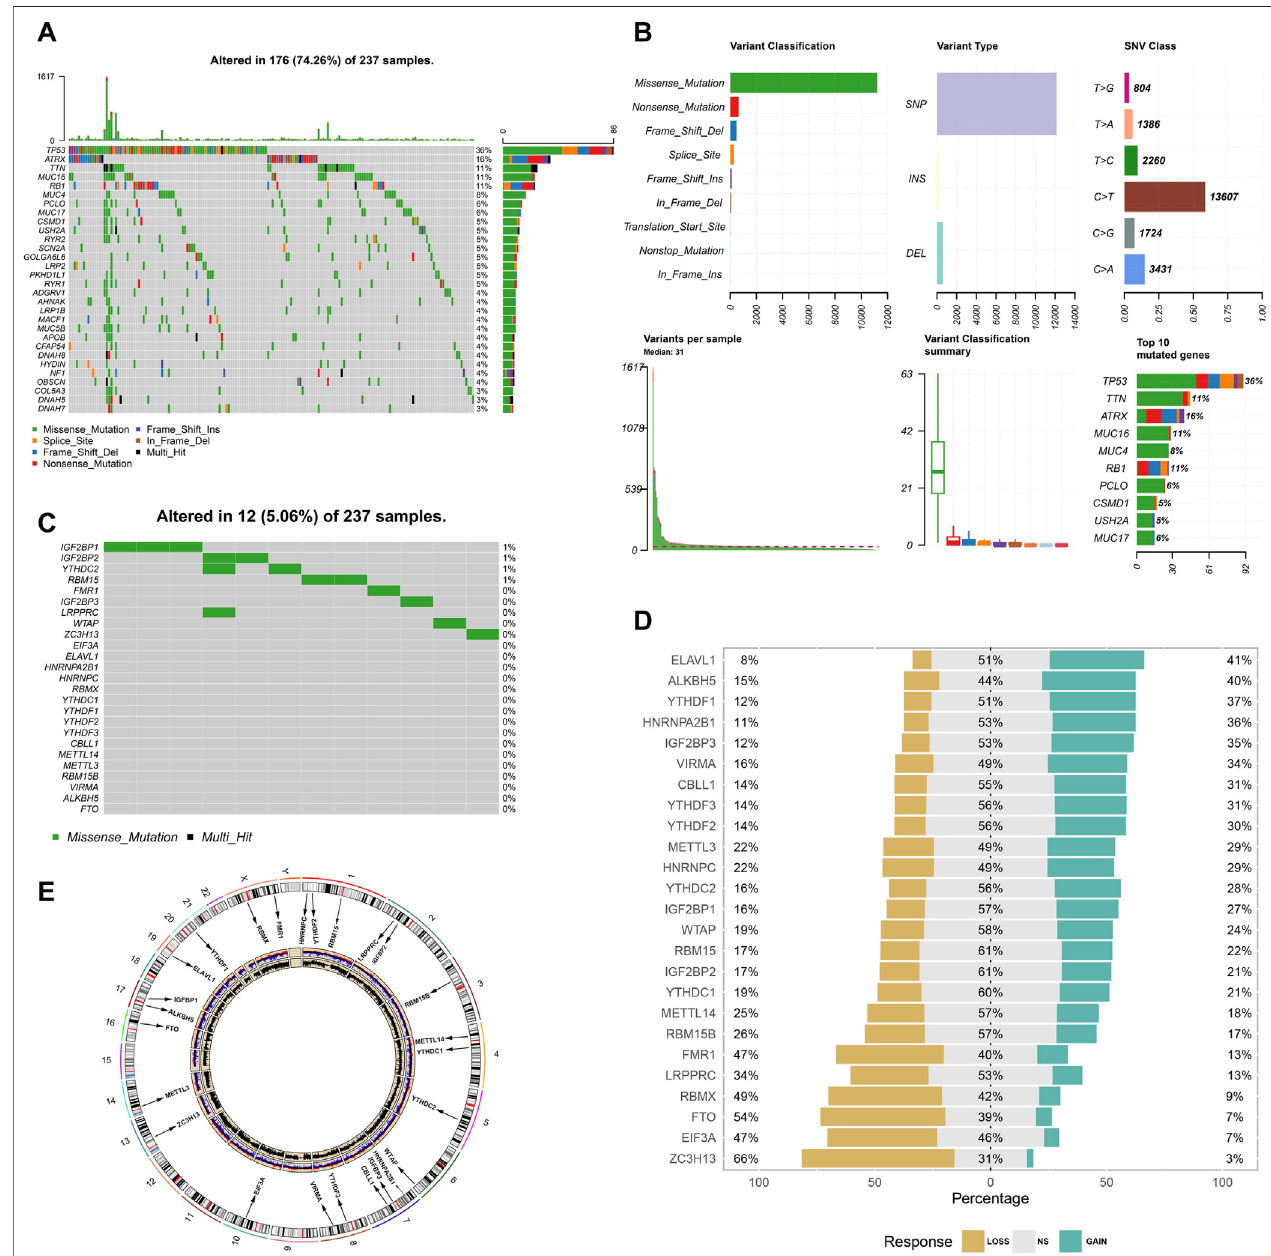
FIGURE1| LandscapeofsomaticmutationsandCNVofm6AregulatorsinSTS. (A) SummaryofsomaticmutationsinSTS; (B) variantclassi fi cationsofmutations in STS; (C) summary of somatic mutations of m6A regulators in STS; (D) CNV of 25 m6A regulators in STS; and (E) locations of different m6A regulators in human